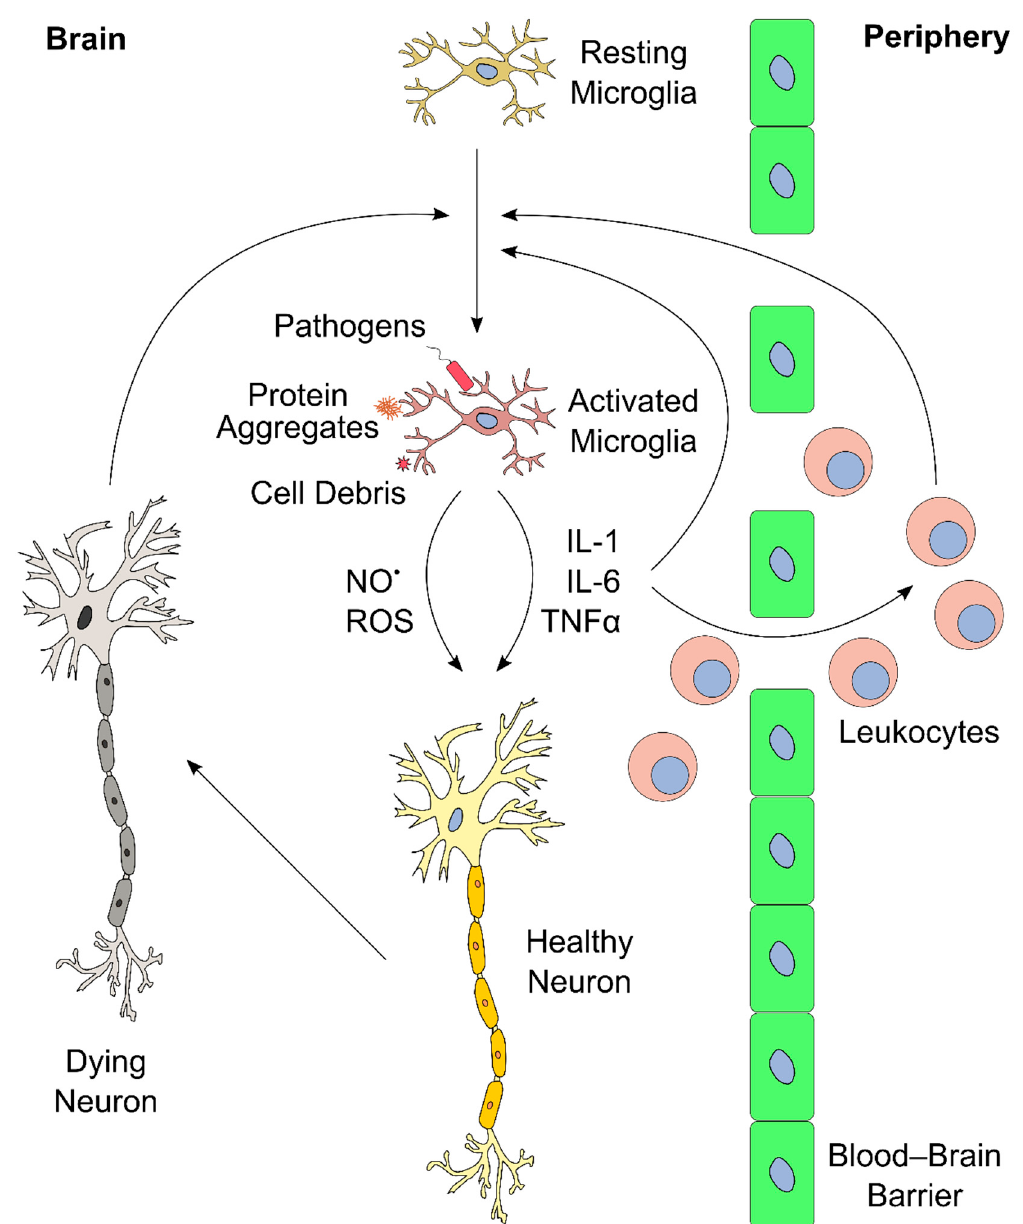
Figure 2. Schematic overview of brain inflammation. Resting microglia in the brain become activated upon exposure to external stimuli (e.g., pathogens, protein aggregates, cell debris). This induces proliferation and release of cytokines (e.g., interleukin-1 (IL-1), IL-6, and tumor necrosis factor α (TNF- α )), reactive oxygen species (ROS), and reactive nitrogen species (RNS, such as NO • ). These inflammatory mediators further stimulate other microglia in the brain. In addition, cytokines and ROS affect neurons, and propagate cell death upon extended exposure, which, in turn, could further stimulate microglia in the central nervous system (CNS). Furthermore, the inflammatory mediators act in the blood–brain barrier, and recruit leukocytes from the periphery into the brain. Leukocytes can perpetuate the inflammatory process even further, for instance, via secretion of additional cytokines. These positive feedback mechanisms can lead to a vicious cycle of inflammation and neuronal death.